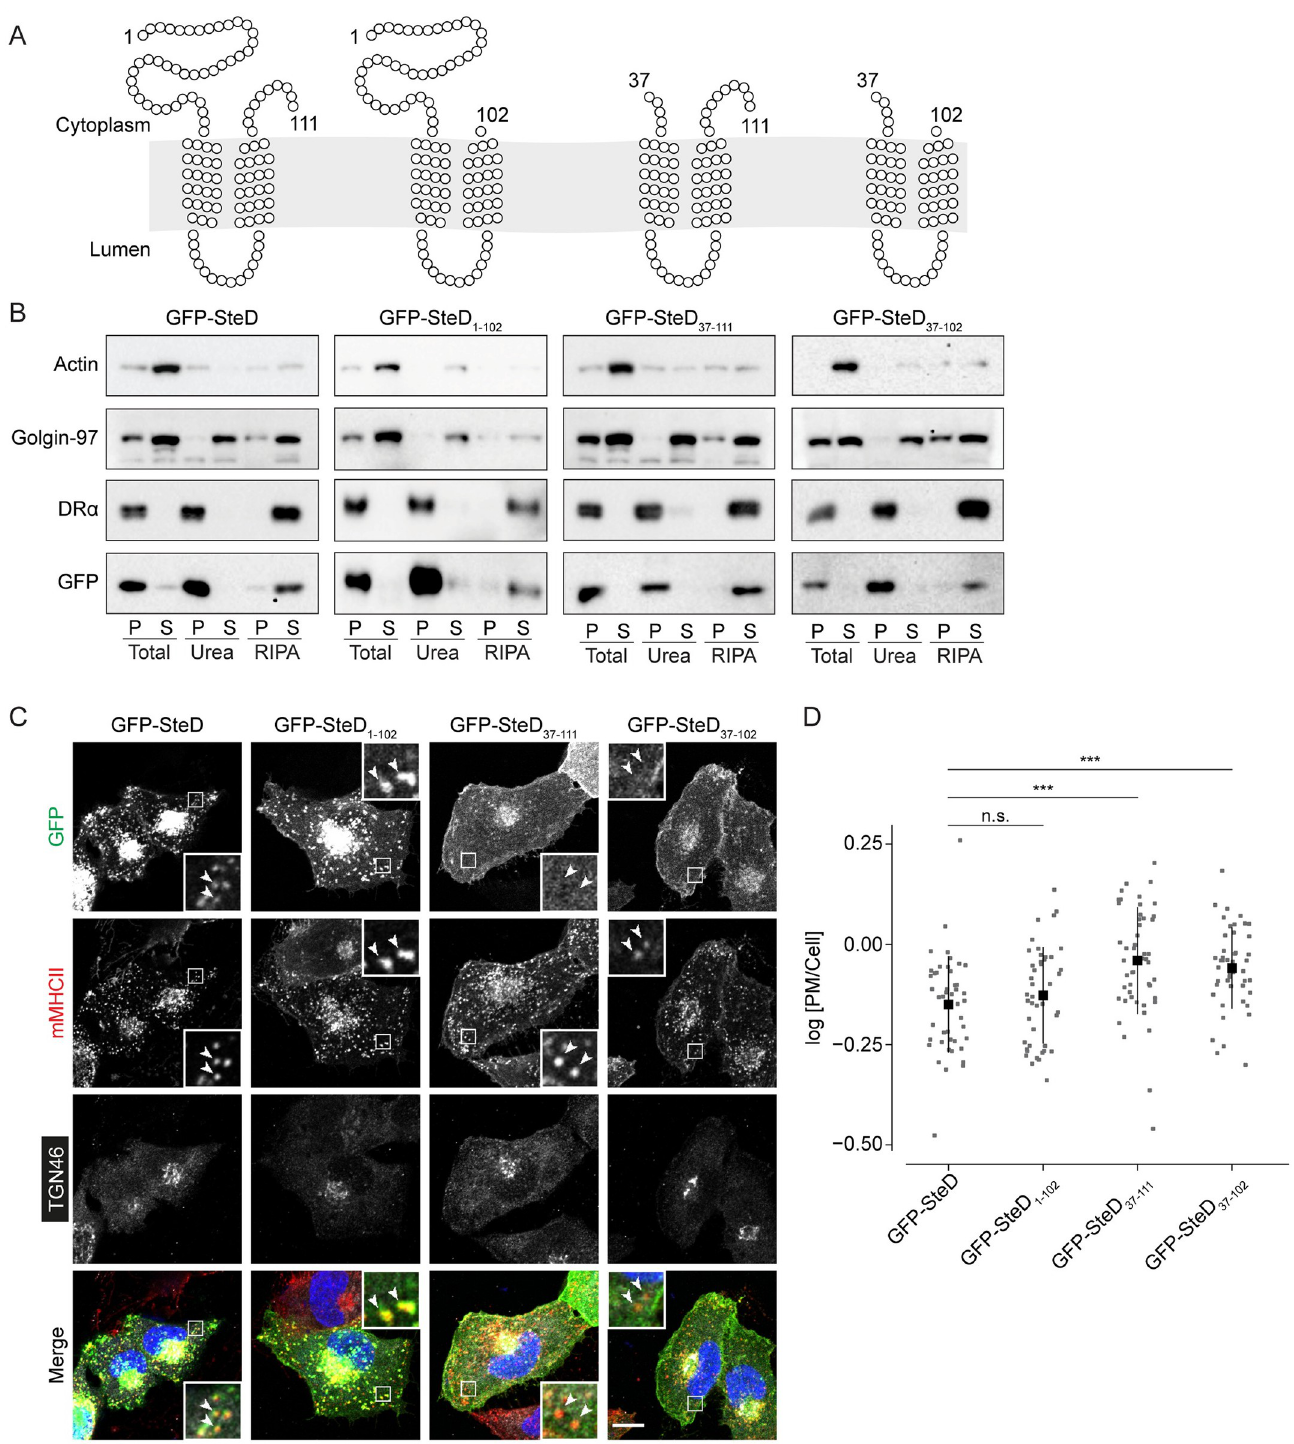
Fig 6. The N-terminal tail of SteD is required for trafficking to MHCII compartments. (A) Schematics of SteD showing predicted transmembrane domains and extent of truncation mutations as indicated. (B) Protein immunoblots of membrane fractionation samples from Mel Juso cells expressing GFP-SteD (wt or mutants). Samples were taken from the pellet (P) and supernatant (S) of the total sample, after urea wash and after RIPA wash. (C) Representative confocal immunofluorescence microscopy images of Mel JuSo cells expressing GFP-SteD (wt or mutants). Cells were fixed and processed for immunofluorescence microscopy by labelling for MHCII compartments (mMHCII, red), the TGN (TGN46, grey), and DNA (DAPI, blue). Arrowheads indicate MHCII compartments.